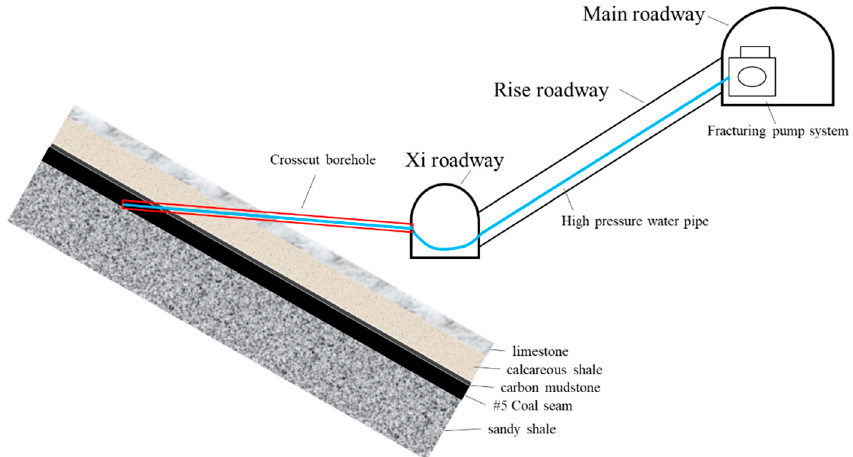
Figure 3. Sketch diagram of high-pressure water injection system.